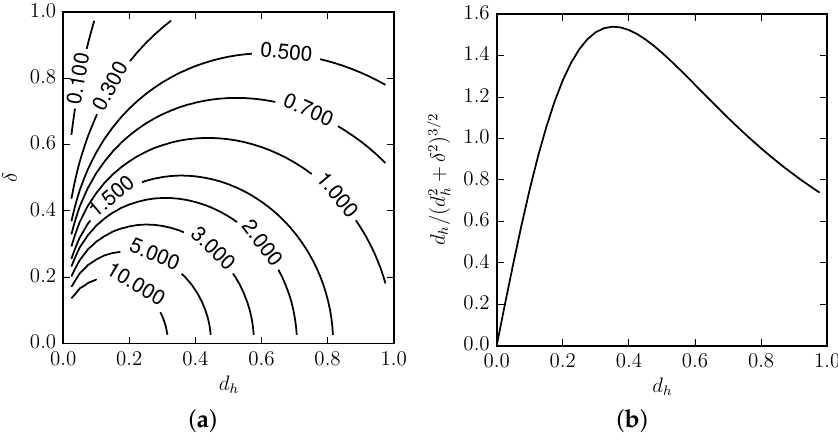
+ δ 2 ) 3/2 in the ( d h